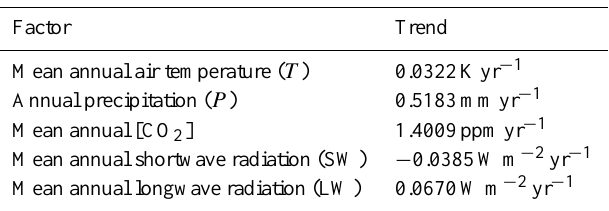
Table 2. Trends in spatial average climate factors from 1960 to